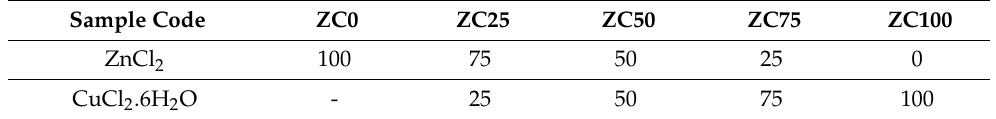
Table 1. Sample codes and corresponding volumes of precursors